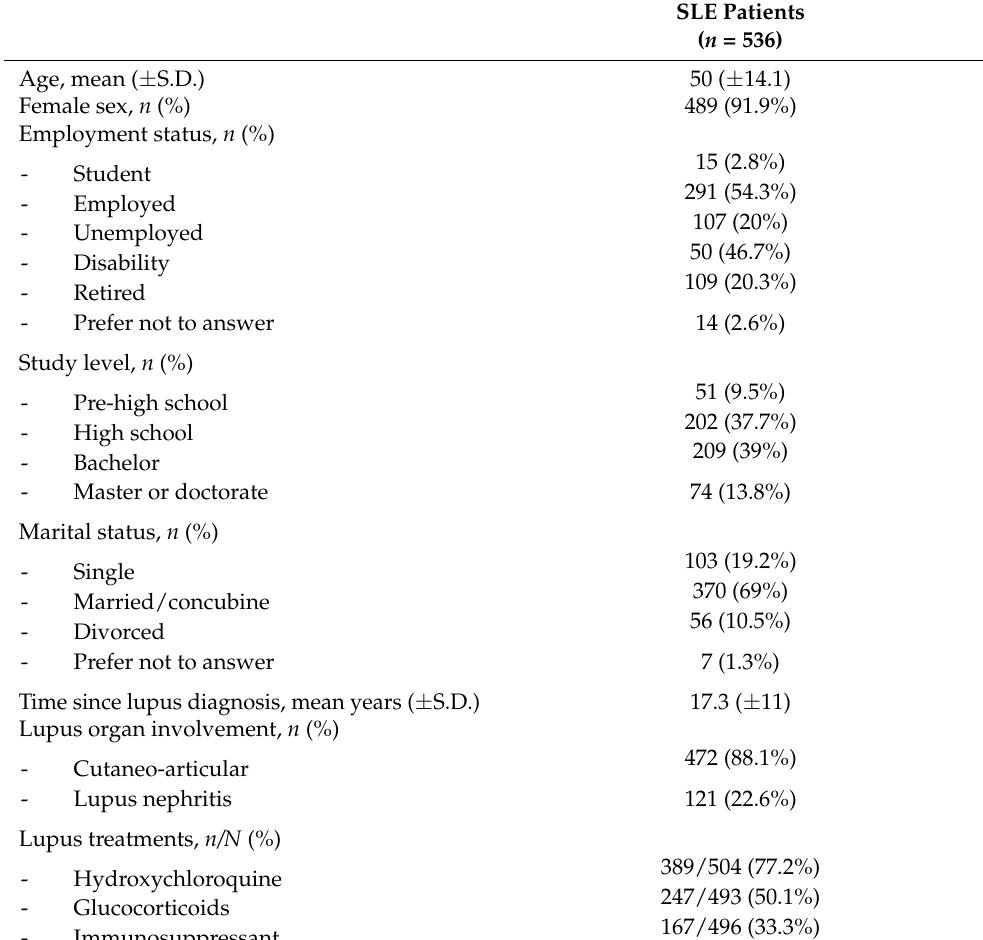
Table 1. Socio-demographical characteristics of the survey